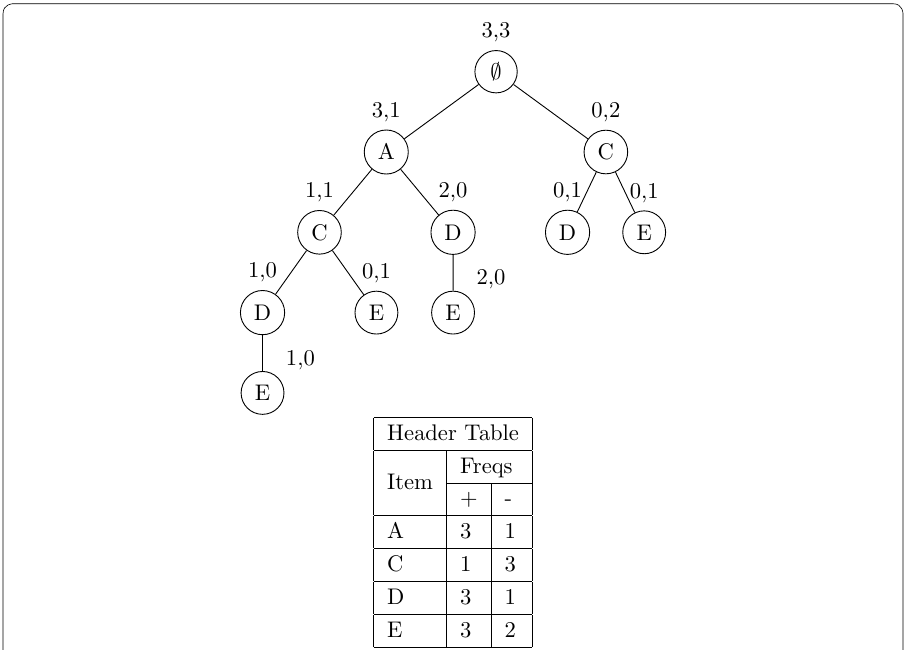
Fig. 1 A CAP-tree example. Built over the toy dataset with minimum support equal to